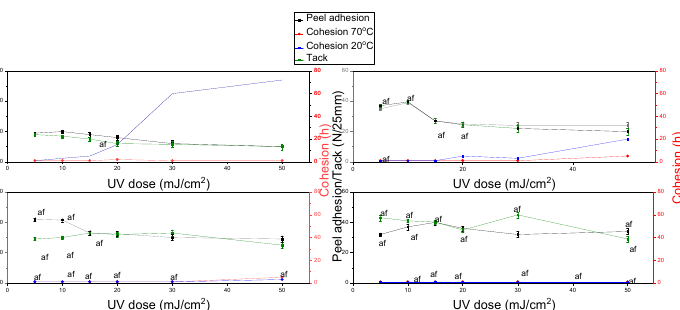
Figure 6. Results of cohesion at 20 °C and 70 °C, peel adhesion, and tack for self-adhesive tapes obtained from acrylate copolymers from P2 synthesis. Figure 7 shows the results for the tapes obtained from the copolymer from the P3 These tapes showed high tack and peel adhesion results, even above 30 N/25 mm. The maximum value of cohesion, above 72 h, was also observed for tapes cross- linked with a higher radiation dose. In the case of pressure-sensitive adhesives, an im- portant aspect is to maintain a balance between adhesion to the substrate and the internal strength of the adhesive layer. Therefore, the copolymer synthesized in the P3 polymeri- zation had the best properties (peel adhesion, cohesion, and tack).